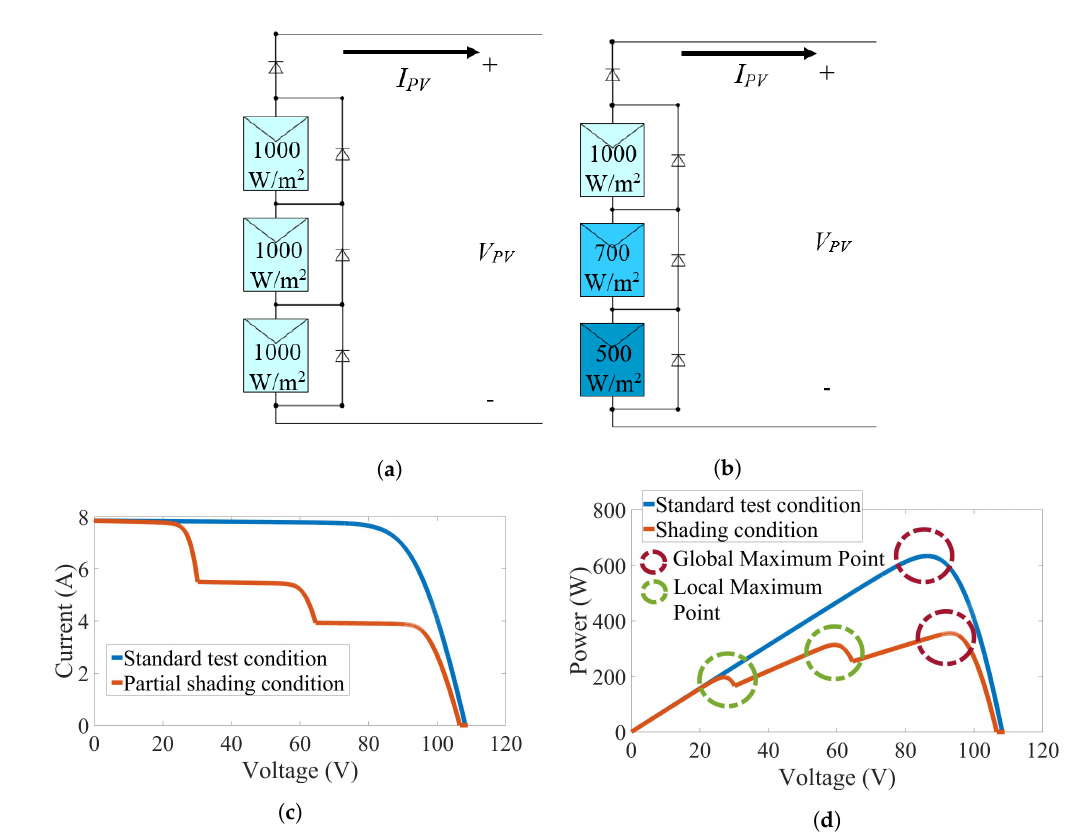
Figure 1. ( a ) Standard test condition at 25 ◦ C, ( b ) Partial Shading condition at 25 ◦ C, ( c ) current–voltage (I–V) characteristic curves for both conditions, ( d ) power–voltage (P–V) characteristic curves for both